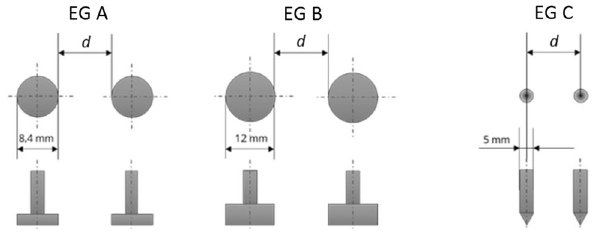
Fig. 6 Electrode arrangements EG A, EG B and EG C